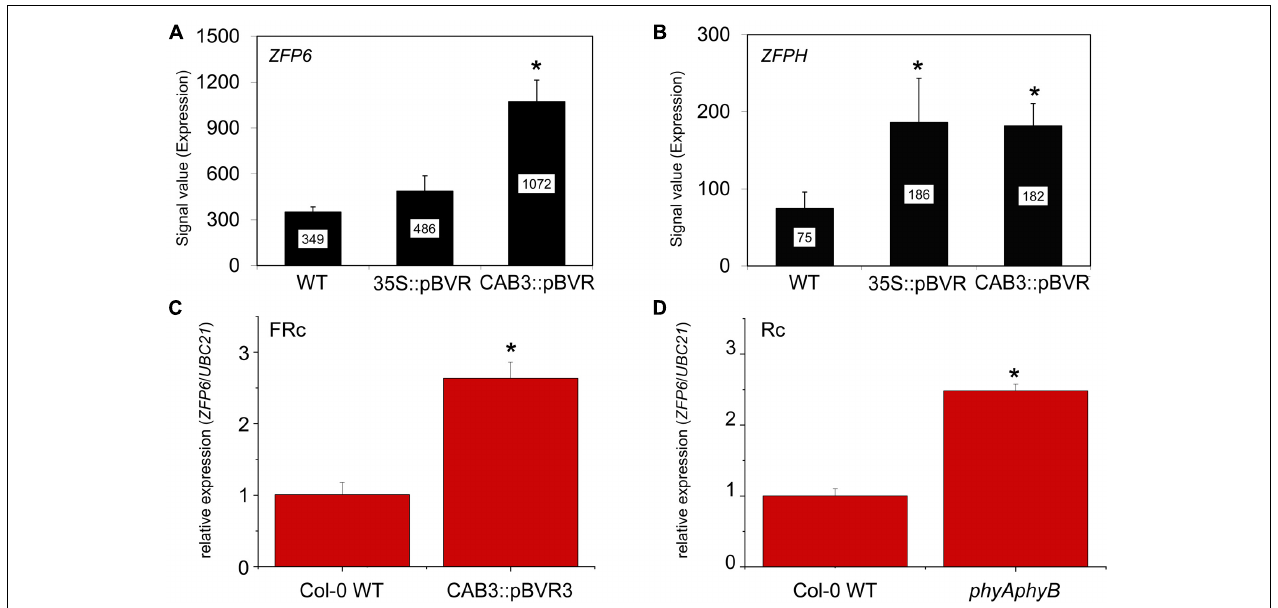
FIGURE 1 | Relative expression of ZFP6 homologs in Arabidopsis seedlings. Expression levels (signal value) of (A) ZFP6 and (B) ZFPH in wild-type (WT), 35S:pBVR, and CAB3:pBVR seedlings grown under continuous far-red (FRc) from published data set (Oh et al., 2013) are shown ( ± SD, n = 3). Signal value indicates signal intensity on the ATH1 array as calculated by Affymetrix Microarray Suite (MAS). (C) ZFP6 relative expression in CAB3:pBVR3 line (Warnasooriya and Montgomery, 2009) in FRc light compared to WT. (D) ZFP6 relative expression in phyAphyB mutant in continuous red (Rc) light conditions compared to WT. (C,D) Seedlings were stratified at 4 ◦ C for 4 days in MS plates with 1% sucrose and then incubated in FRc or Rc light for 7 days. Gene expression data were obtained following the 2 − (cid:49) CT method using UBC21 as the reference gene. Means ± SD were calculated from at least three biological replicates. * p ≤ 0.05, relative to